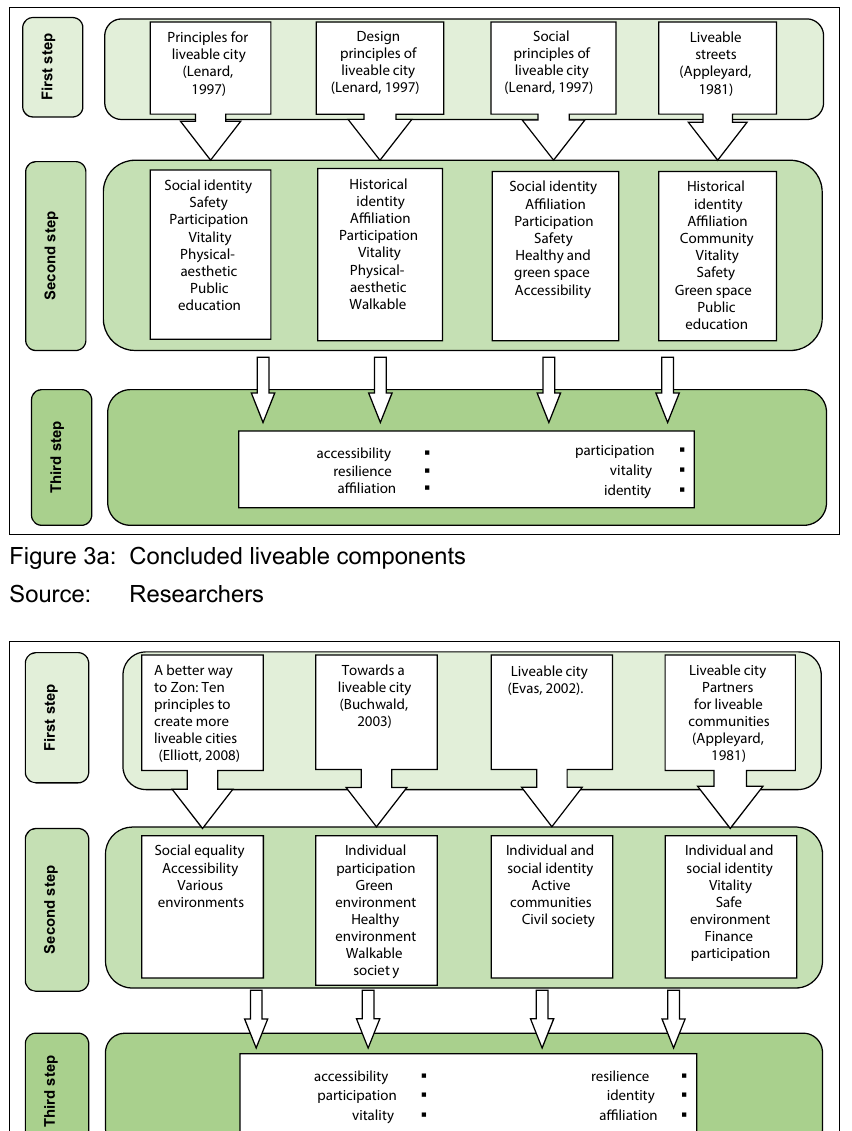
Figure 3b: Concluded liveable components Source: Researchers